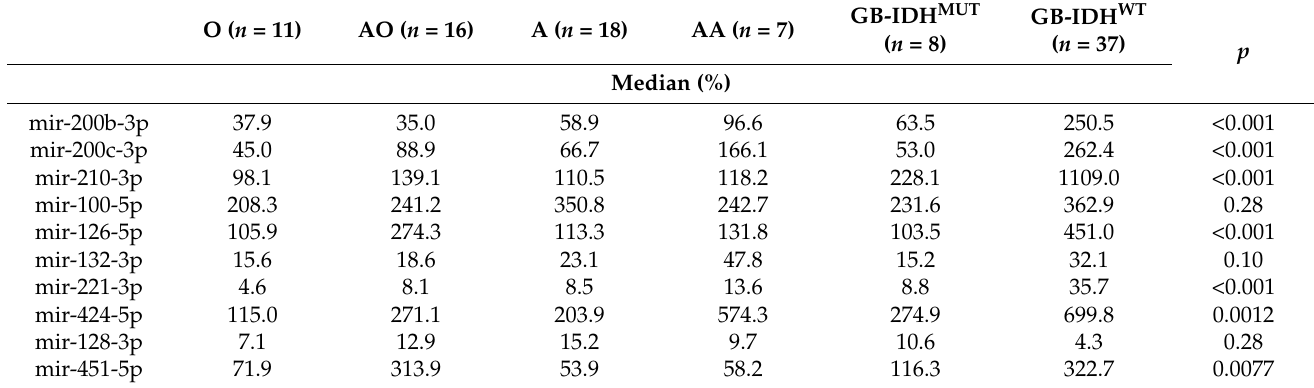
Table 4. MiRNA expression according to the WHO 2016